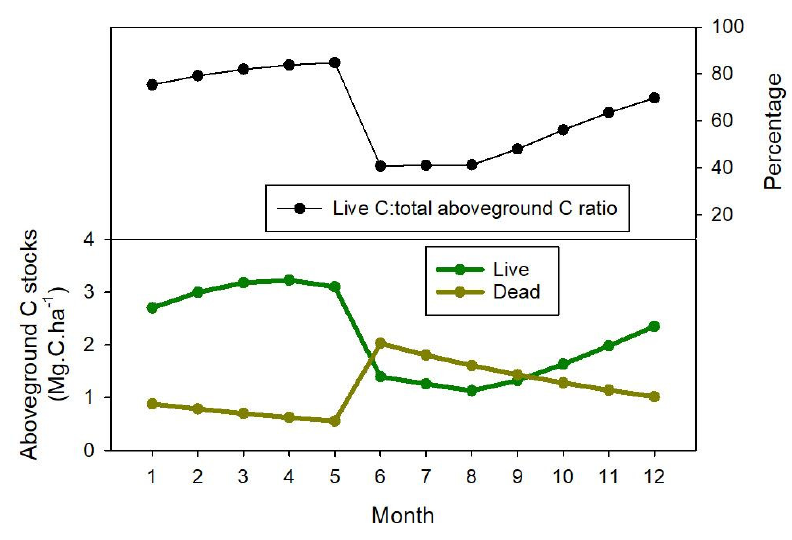
Figure 5. Seasonal pattern of estimated carbon stock for live and dead aboveground biomass in grassland areas of the Cerrado biome in 2019.